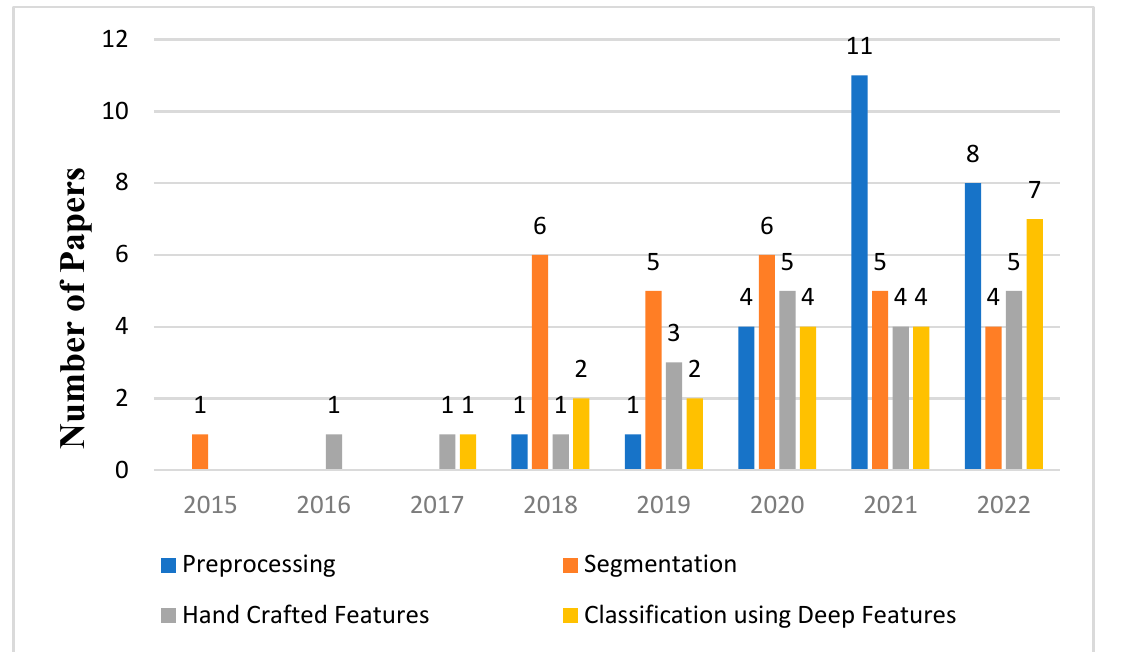
Figure 3. Overview of research strategies/methods for DR detection.